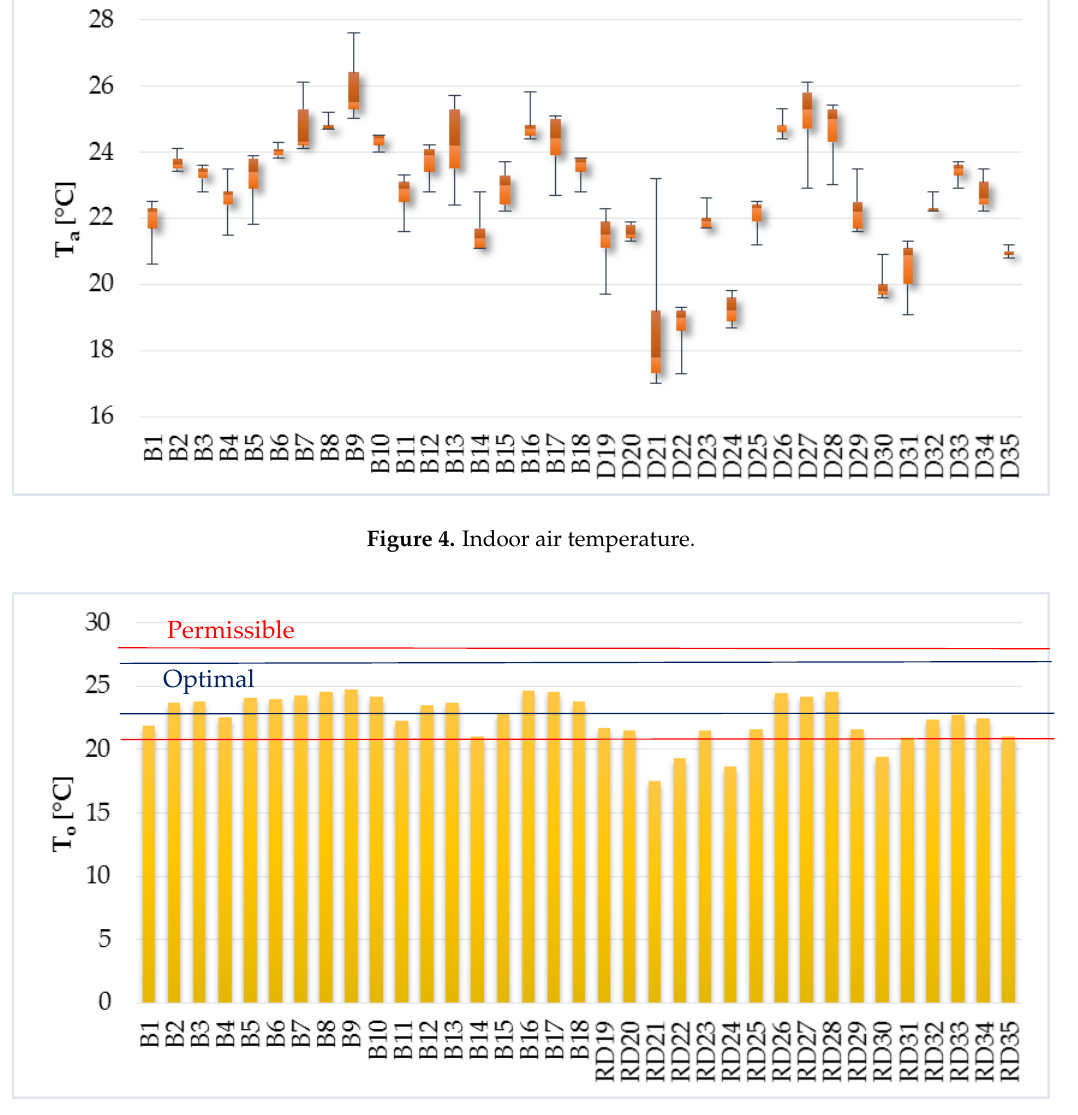
Figure 6. Relative humidity. The limit value for PM 10 concentrations is determined at 50 µg/m 3 for 24 h exposure in the Decree no. 210/2016 [37]. The results from measurement in the selected households cannot be compared with this legislative requirement since the measurement not lasted 24 h. However, the intention for measurement of PM levels was to find out whether there is dependence between the TVOC concentrations and individual PM fractions. The average concentrations of PM 0.5 -PM 1 -PM 2.5 -PM 5 - PM 10 were in the apartments and family houses as follows: 5.4; 5.8–8.1; 8.3–14.3; 13.1–44.1; 44.5–81.0; 87.8 µg/m 3 . Levels of PM 2.5 and PM 10 are illustrated in Figures 7 and 8.